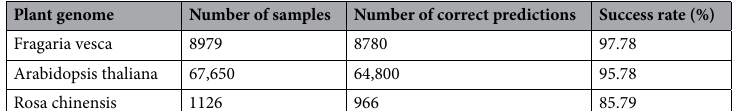
Table 5. 6mA site identification performance of i6mA-CNN on three plant genomes.